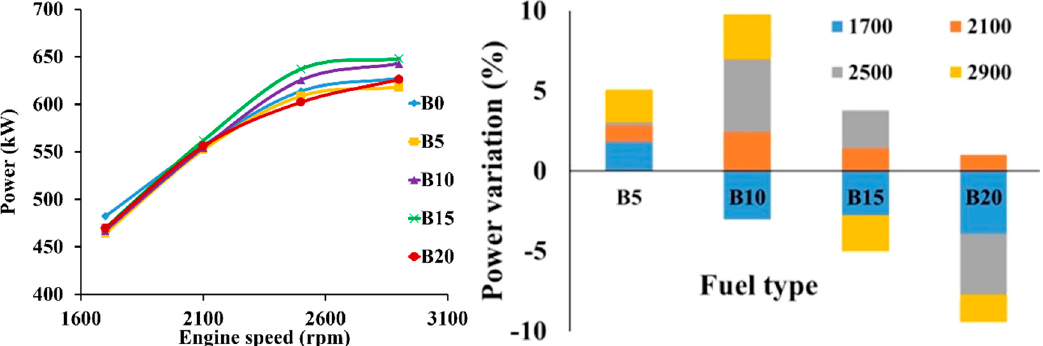
Figure 3. Variation of engine power (kW) for different engine speeds and diesel biodiesel blends at full load.